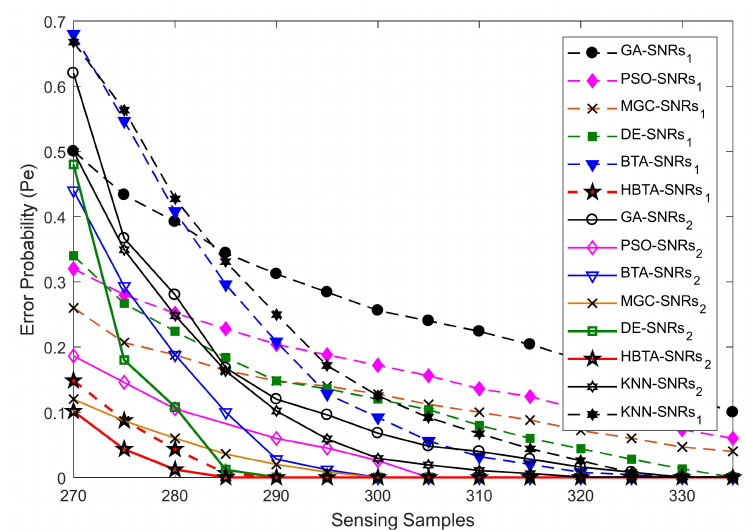
Figure 11. Error probability vs. sensing samples in the presence of AN-ANC users with SNRs 1 ( − 9.5 dB) and SNRs 2 ( − 0.5 dB).